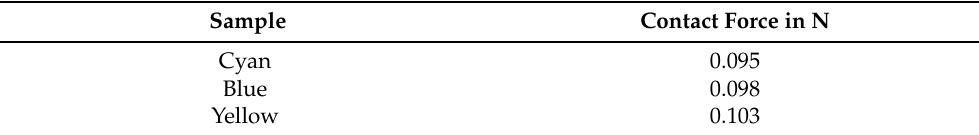
Table 2. Applied contact forces for each silicone sample.